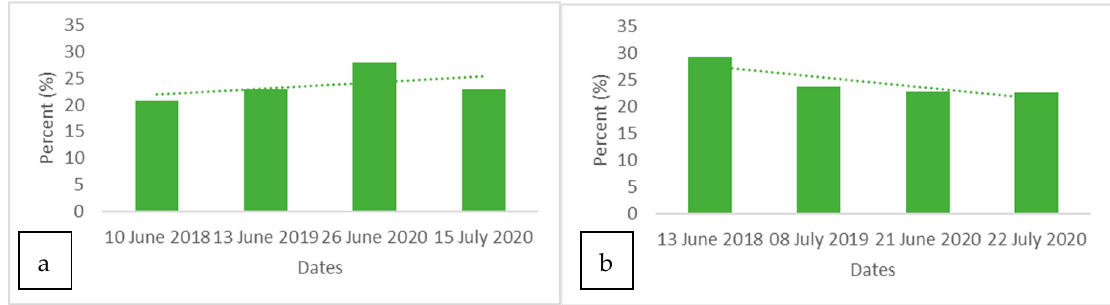
Figure 2. Variations of small urban green areas per image for Bucharest ( a ) and Athens ( b ). The dynamics of the small urban green areas were analyzed by overlapping the four images for each city. In Bucharest, 37.11% of the surface of small urban green areas was identified as green on all four images (100% overlap), 18.57% overlaps on three images (>50% overlap), and 18.87% on two images (<50% overlap), while 25.44% of the green sur- face only appears on one of the classified images (Figure 3a). In Athens, 36.5% of the sur- face of the identified small urban green areas were distributed in this category in all four analyzed moments, while 15.67% are classified as green on three images (>50% overlap), 22.41% on two images (<50% overlap), and 25.41% appear on only one image (Figure 3b).